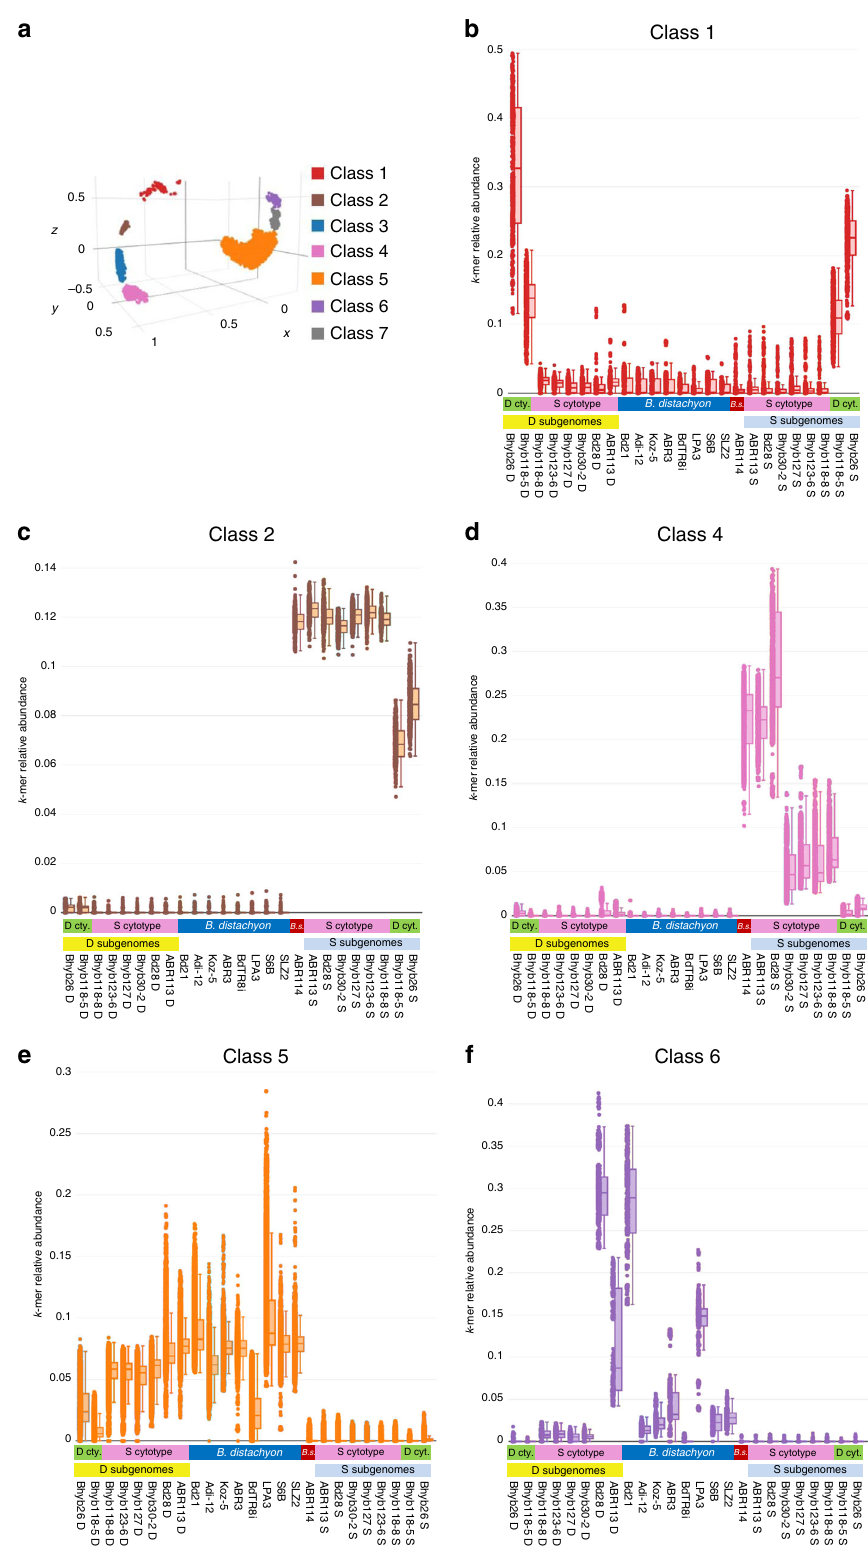
variation among B. distachyon genomes. Overall, the D subgenomes looked like typical B. distachyon genomes in terms of the propor- tions of shell, soft-core and core genes (Fig. 7). We did note that the D subgenome from the B. hybridum D-plastotype line Bhyb26 was missing more B. distachyon core genes (genes found in all B. dis- tachyon lines) than the other B. hybridum lines. To compare this